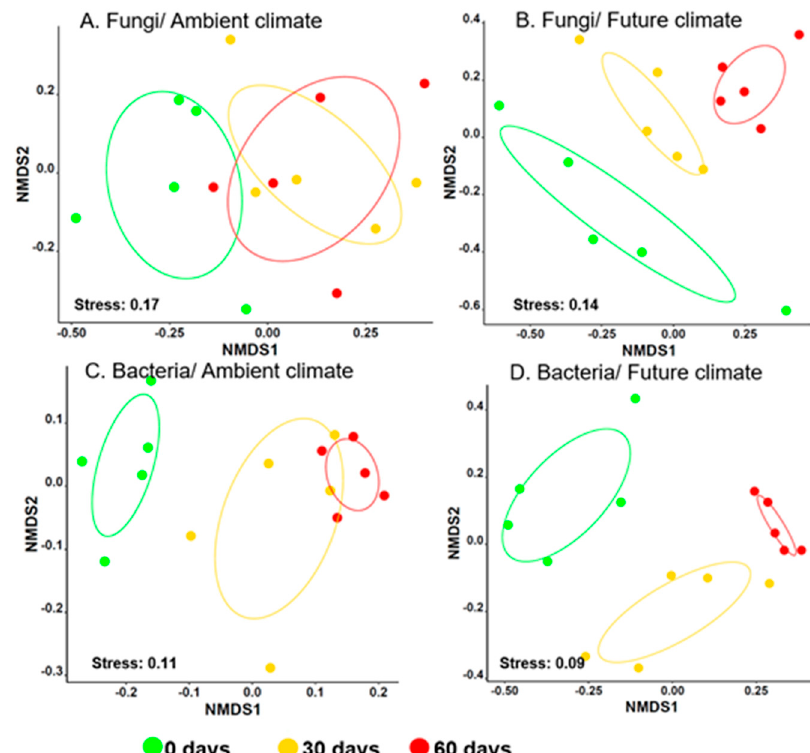
Figure 1. Non-metric multidimensional scaling (NMDS) ordination diagrams of the fungal community colonizing wheat straw residues in ( A ) ambient and ( B ) future climate treatments; the bacterial community in ( C ) ambient and ( D ) future climate